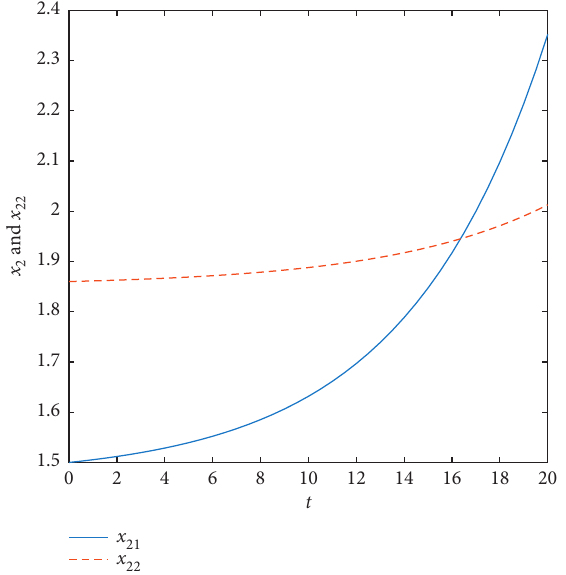
Figure 7: The pollution abatement investment trajectory of the downstream region under noncooperation.